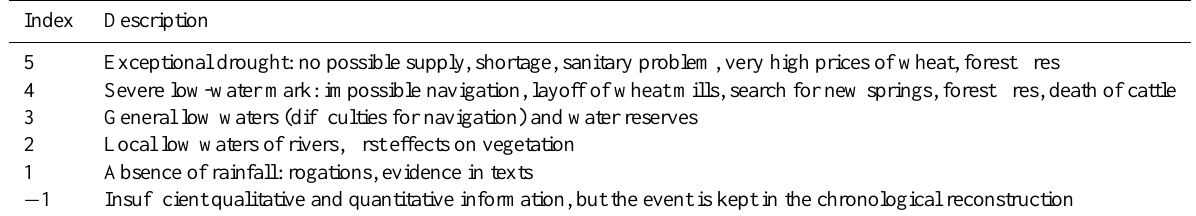
Table 4. Severity classes and description for 16th–19th century drought events (Garnier, 2010a,